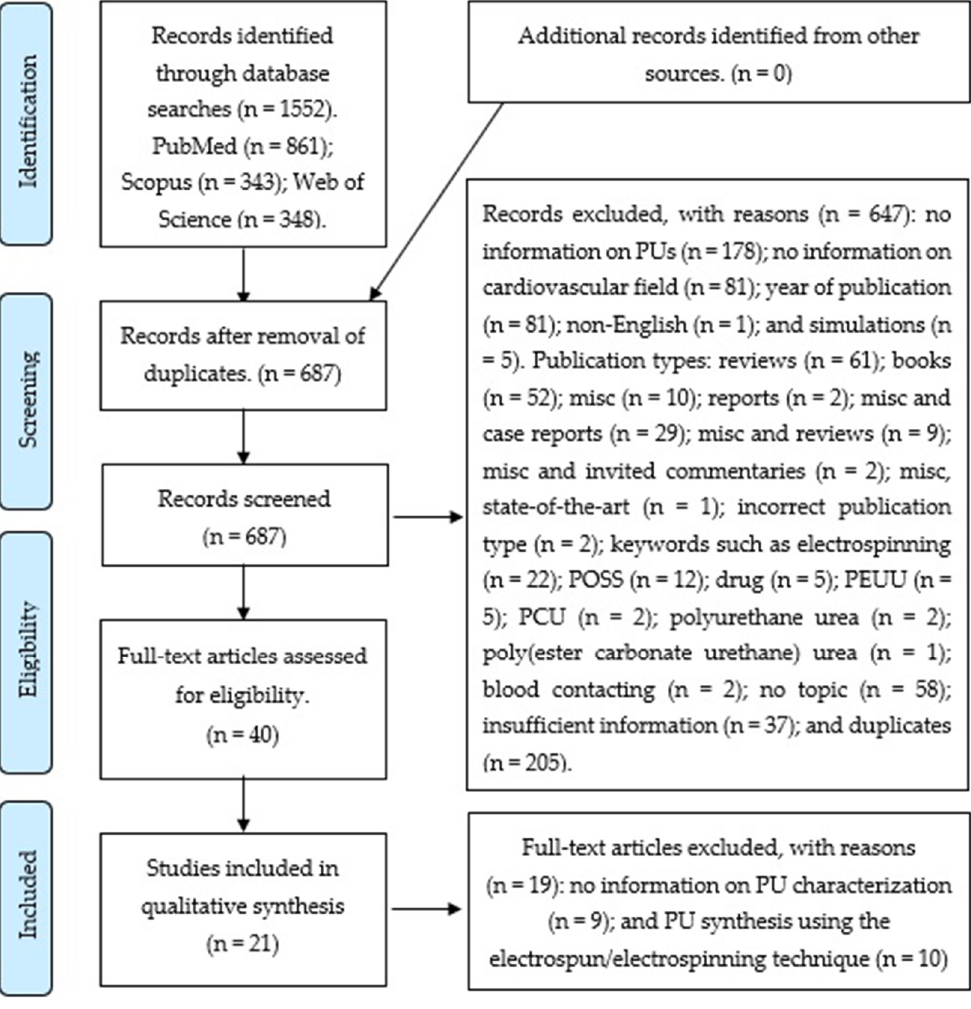
Figure 1. Preferred Reporting Items for Systematic Reviews and Meta-Analyses (PRISMA) flow Figure1. diagram.